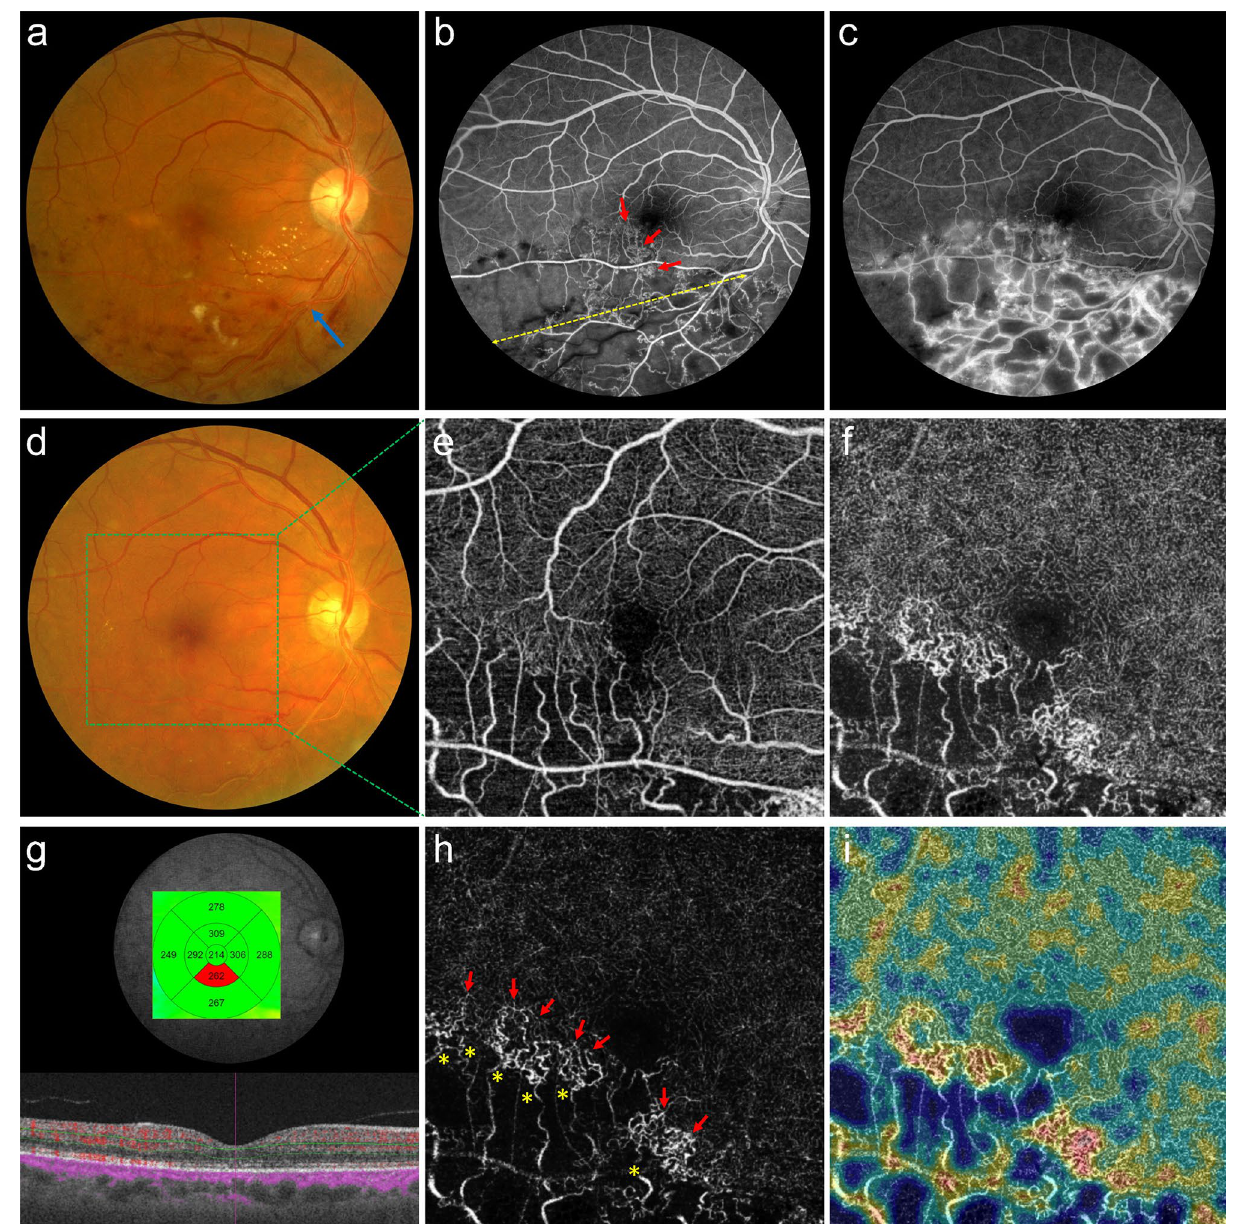
Figure 1. Patient selection and capillary congestion at baseline. ( a ) A patient presented with acute major branch retinal vein occlusion (BRVO) at the right inferotemporal arteriovenous crossing (blue arrow). ( b , c ) Three months after the initial visit, a wide capillary nonperfusion area (yellow dotted double arrow) is shown on fluorescein angiography (FA), confirming ischemic BRVO. FA presents collateral vessels (red arrows) with fluorescein leakage at the late phase. ( d ) He reached stable macula at baseline 20 months after the initial visit with seven anti-vascular endothelial growth factor intravitreal injections and sectorial photocoagulation. ( e , f ) At baseline, en-face optical coherence tomographic angiography corresponding to the green box area reveals the nonperfusion areas on superficial and deep capillary plexuses (DCP). ( g ) The central subfield macular thickness was 214 µm without any fluids at baseline. ( h ) The gamma was adjusted to clarify the capillary congestion of DCP (DCP-C) from the ( f ) image. The retinal arterioles (yellow asterisks) from the nonperfusion area supply flow to DCP-C, and the flow drains to the central vortex venules on the opposite side (red arrows). ( i ) Abundant flows of DCP-C were noted on the composite image of en-face DCP and the color-coded vessel density